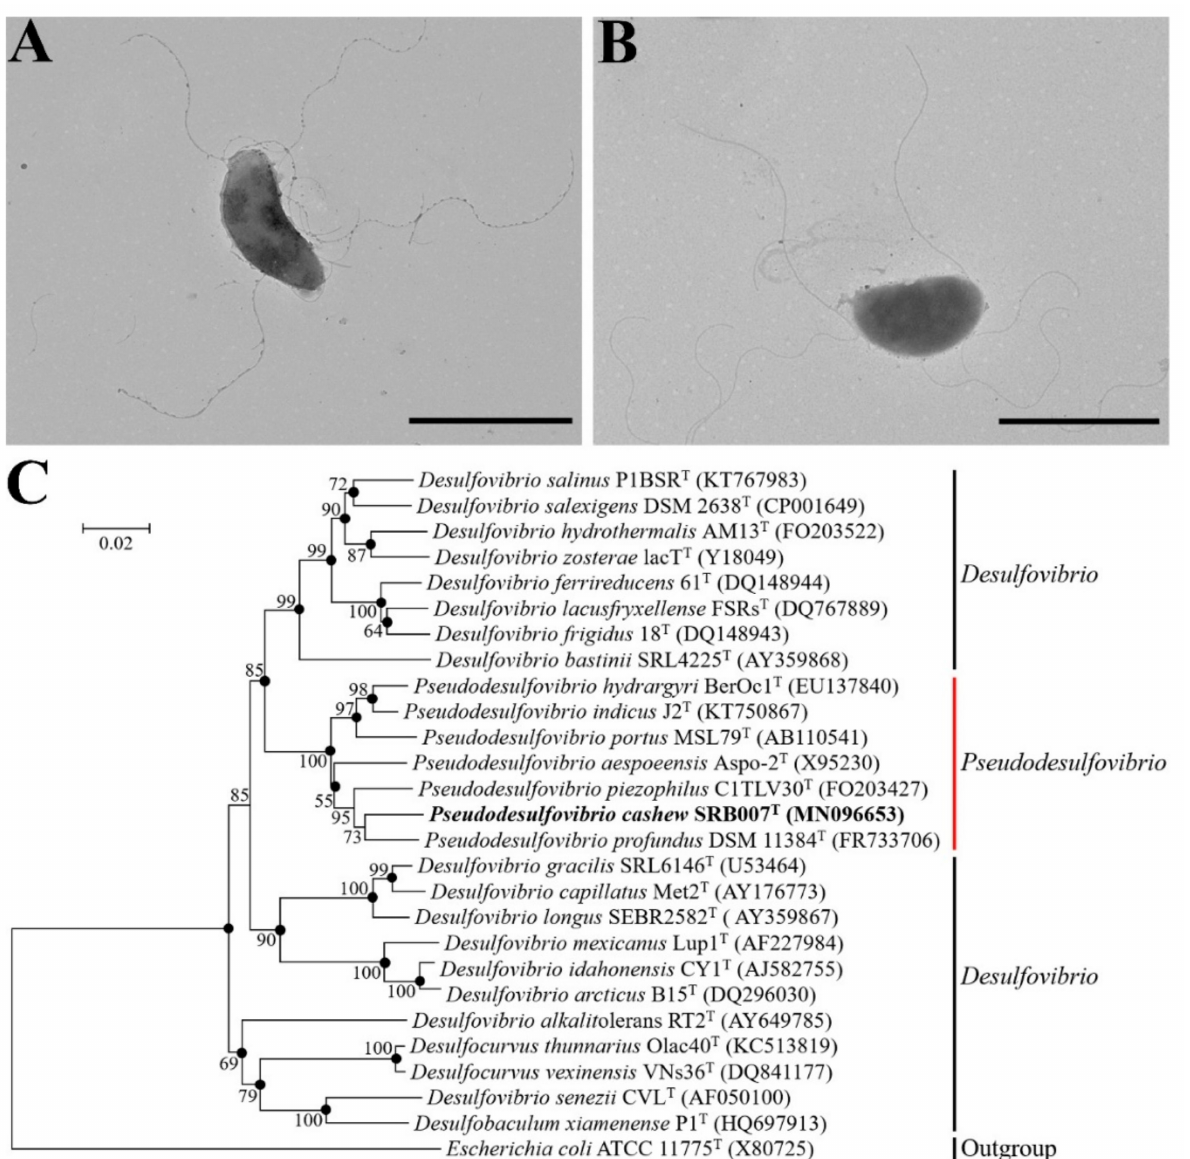
Figure 1. Morphology observation and phylogenetic analysis of P. cashew SRB007. ( A , B ) Morphology observation of P. cashew SRB007 by transmission electron microscopy (TEM). The bars in panels A and B were both 2 µ m. ( C ) Phylogenetic tree based on 16S rRNA gene sequences of P. cashew SRB007 and related strains reconstructed by the neighbor-joining method. GenBank accession numbers are given in parentheses after strain names. Bootstrap values were based on 1000 replicates. Bar, 0.02 substitution per nucleotide position. The strain indicated with bold font represented strain SRB007 identified in this study. Escherichia coli ATCC 11775 T (GenBank accession number X80725) was used as the